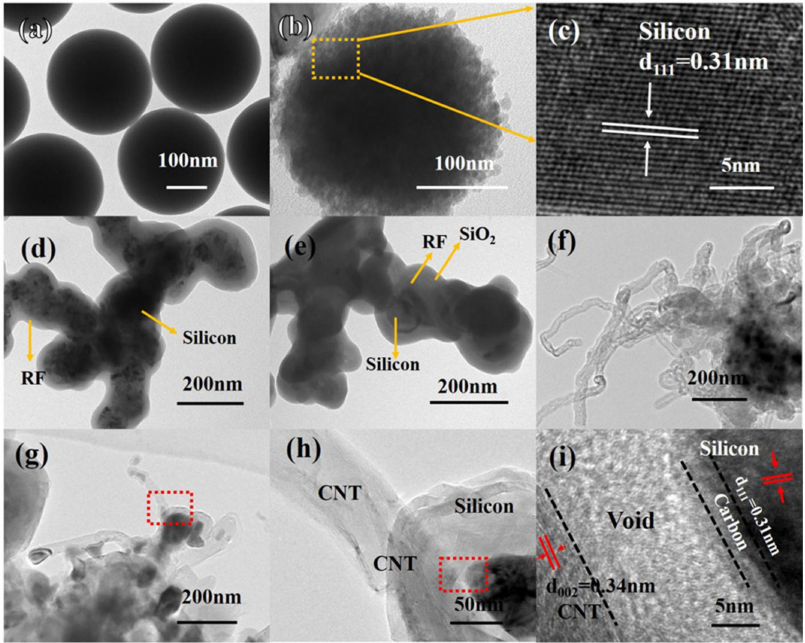
Figure 3. Transmission electron microscope (TEM) images of SiO 2 NPs synthesized by the well- established Stöber method ( a ), reduced Si NPs in the MR process ( b ), high resolution TEM (HRTEM) images of Si NPs ( c ), TEM images of Si@RF ( d ), Si@RF@SiO 2 ( e ), and Si@C@v@CNTs ( f – h ),